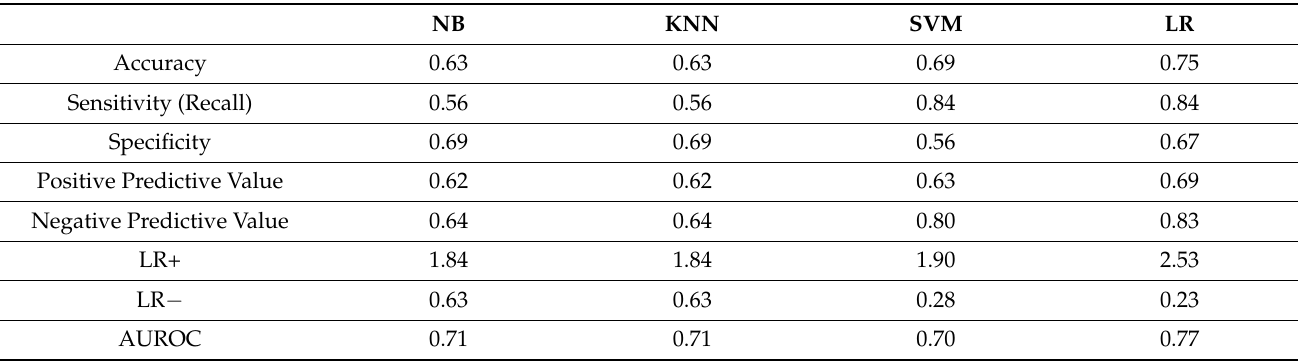
Table 3. Test Metrics of the models tested. One can see that LR got the best metrics.